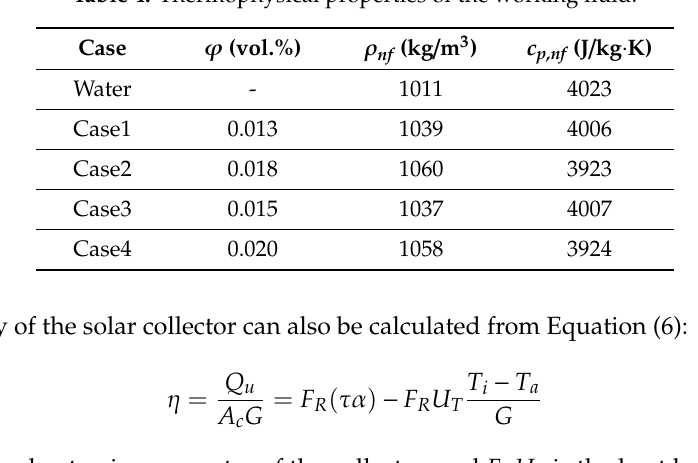
Table 4. Thermophysical properties of the working